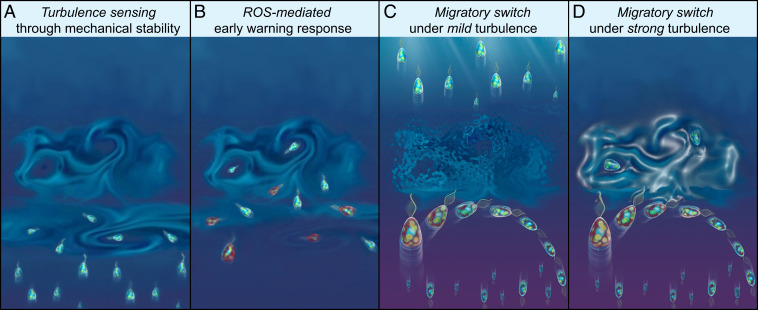
A ROS-mediated early-warning system could help H. akashiwo evade the damaging effects of turbulence. (A) A population migrating vertically by gravitaxis encounters a turbulent patch that disrupts the cells’ migratory pattern and could result in damage or death. Cells sense the intensity of a microscale turbulent eddy through their mechanical stability. Less stable cells are more easily thrown off balance and tumble under the effect of turbulence. (B) Cells integrate ROS signaling generated by tumbling events through a mechanism regulated by their scavenging machinery. Within timescales as short as tens of seconds, a bistable stress response mediates the emergence of two subpopulations with opposite migratory direction. Cells shown in red have accumulated higher levels of ROS. (C and D) The population splits into two subpopulations: one that continues to migrate upward and one that switches to downward migration to avoid the turbulence. Cells change the direction of their vertical migration by rapidly changing their cellular morphology, which, together with the internal distribution of organelles, governs the migration direction (16). (C) If the turbulence is weak (ε < 10−6 W · kg−1), cells from both subpopulations survive, with upward migrating cells continuing their journey to well-lit surface waters to photosynthesize and divide. (D) If the turbulence is strong (ε > 10−6 W · kg−1), upward-swimming cells may get trapped, lose motility, and possibly perish. By avoiding the turbulent patch, the downward-swimming cells suffer a reduction in growth because of elevated levels of ROS and a reduction of photosynthetic efficiency, but provide a reservoir to re-establish the population. In this manner, the behavioral split into two subpopulations creates an evolutionary advantage for the population overall.